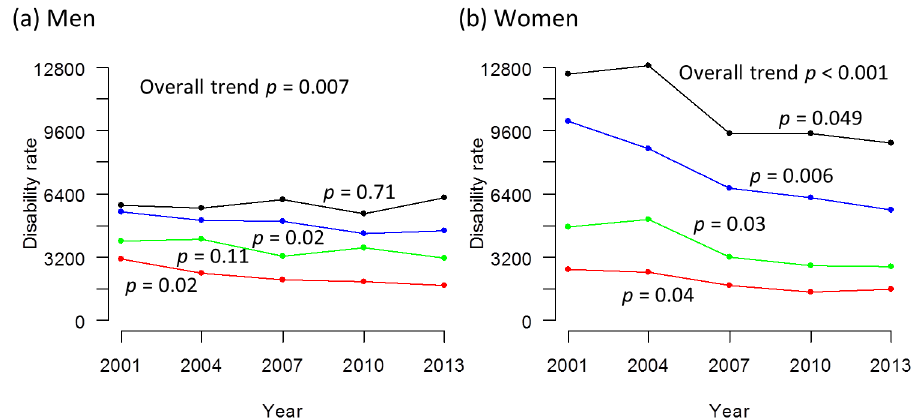
Fig 1. Trends in disability rate in men and women from 2001 to 2013. (a) men. (b) women. The disability rate is the rate of persons certified for long-term care under the Long-Term Care Insurance System per 100,000 population. The black line represents those aged 80 – 84 years, the blue line represents those aged 75 – 79 years, the green line represents those aged 70 – 74 years and the red line represents those aged 65 – 69 years. The p values signify statistical significance for the trends in each age